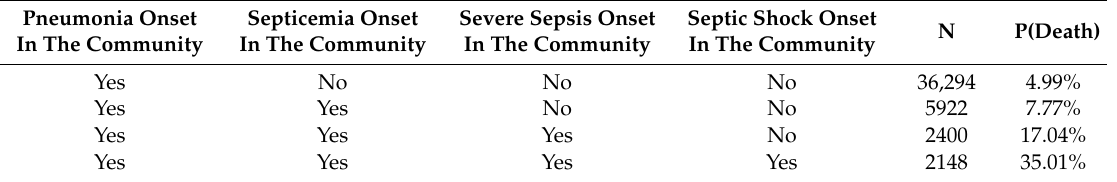
Table 3. Community onset of pneumonia induced bloodstream infection.